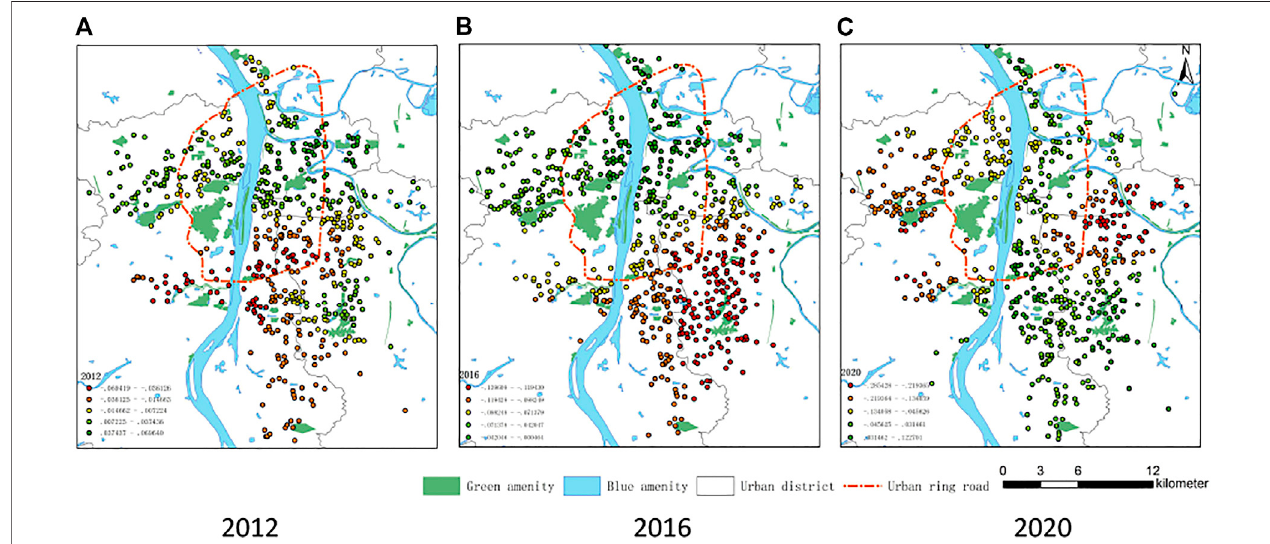
FIGURE 6 | Spatial and temporal variation of WP in fl uenced coef fi cients in 2012, 2016 and 2020.